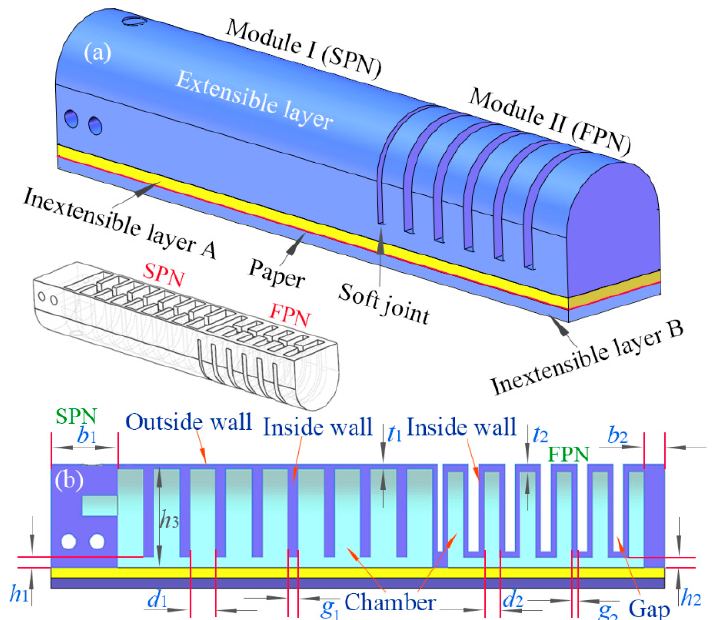
Figure 1. The schematic diagram for the structure of the newly proposed soft pneumatic actuator: ( a ) the structural component of the soft actuator and ( b ) a cutaway view and the relevant geometric parameters.